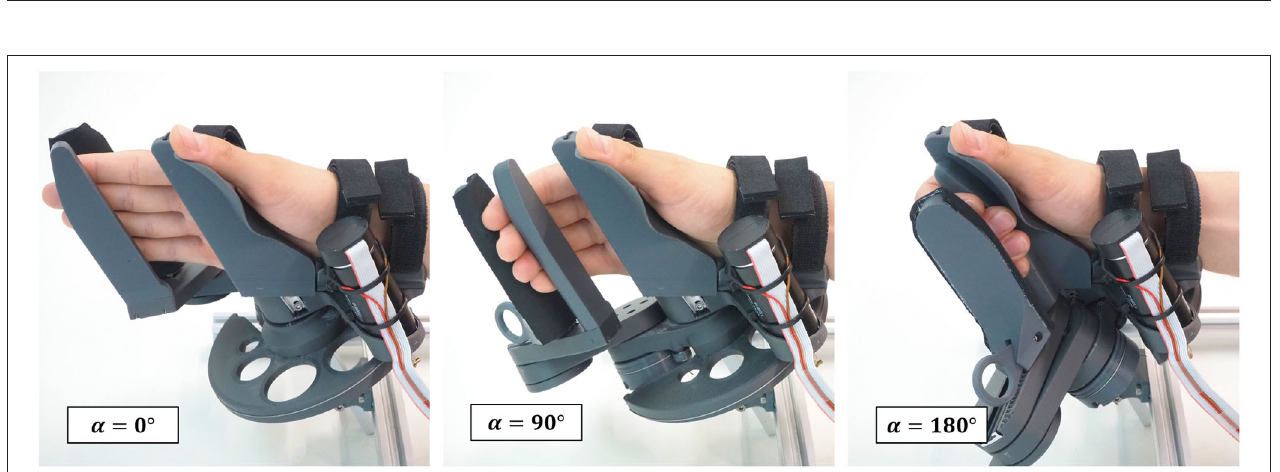
FIGURE 11 | Hand movement sequence from full finger extension to 180 ◦ flexion for a hand of size medium-large .